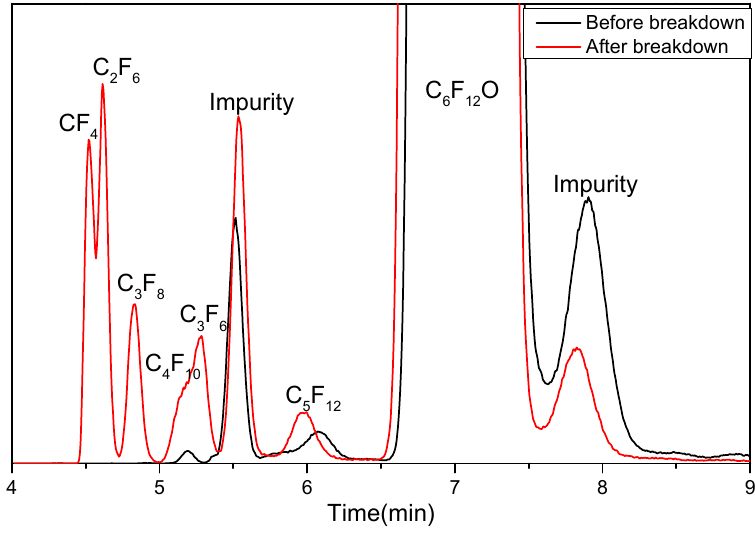
Figure 4. Test results of C 6 F 12 O/N 2 mixed gas decomposition components.